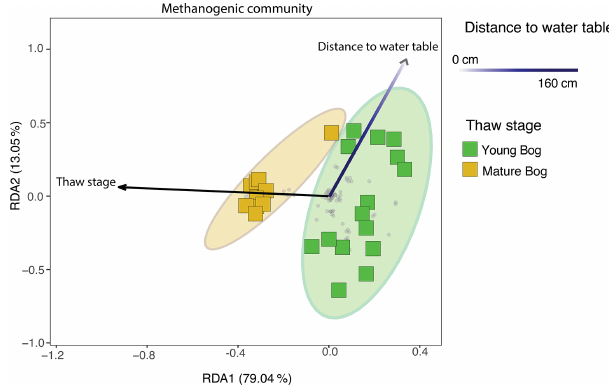
Figure 6. Redundancy analysis (RDA) exploring significant biotic and abiotic variables influencing the total methanogenic commu- nity (adjusted R 2 = 27 . 6%), as determined by a backward stepping RDA model in the peat and pore water samples. All parameters that were used in the model are described in Sect. 2.1 of the “Methods”. Grey dots in the panel demonstrate the distribution of all ASVs in the methanogenic dataset. Shaded ellipses represent the 95% confidence intervals for microbial community structure according to peatland thaw stage (young bog versus mature bog). Only sig- nificant (ANOVA: P< 0 . 05) variables are shown. Using variation partitioning, we found that peatland thaw stage significantly ex- plains about 18.4% of methanogenic community variation, whereas distance to water table explained 4.3%. Both axes are significant (ANOVA: P< 0 .